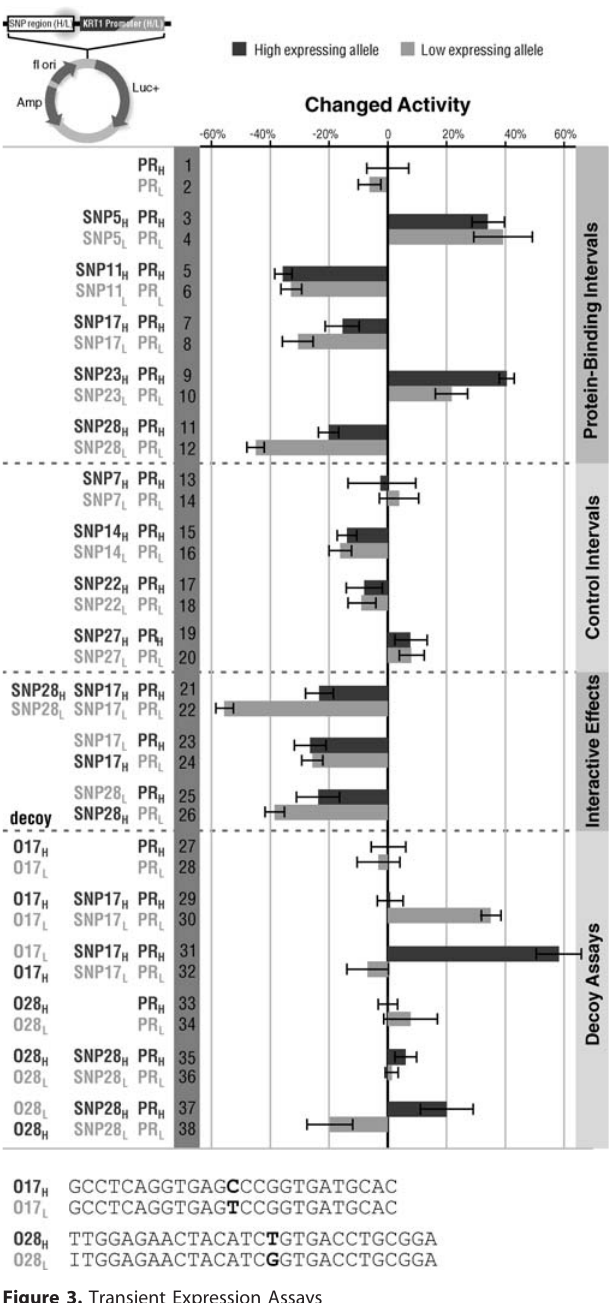
Figure 3. Transient Expression Assays Luciferase reporter constructs containing either the low (L) or the high (H)-expressing KRT1 promoter (PR H or L ) or the promoter combined with SNP-containing interval(s) are shown on the left (numbered 1–26). Relative KRT1 promoter activity of constructs 2–26 is expressed in % versus control construct PR H (assay 1). The relative luciferase activities represent the mean 6 standard deviation of two to three independent experiments performed in triplicate or quadruplicate. Double-stranded decoy oligonucleotides, O17 H or L and O28 H or L (sequences shown at bottom), co-transfected with the KRT1 promoter alone and in various combinations with the H and L SNP17 and SNP28; constructs are shown for numbers 27–38. The relative KRT1 promoter activity of constructs 28– 32 is expressed in % versus control construct 27, the relative activity for constructs 34–38 is expressed in % versus control construct 33. DOI: 10.1371/journal.pgen.0020093.g003